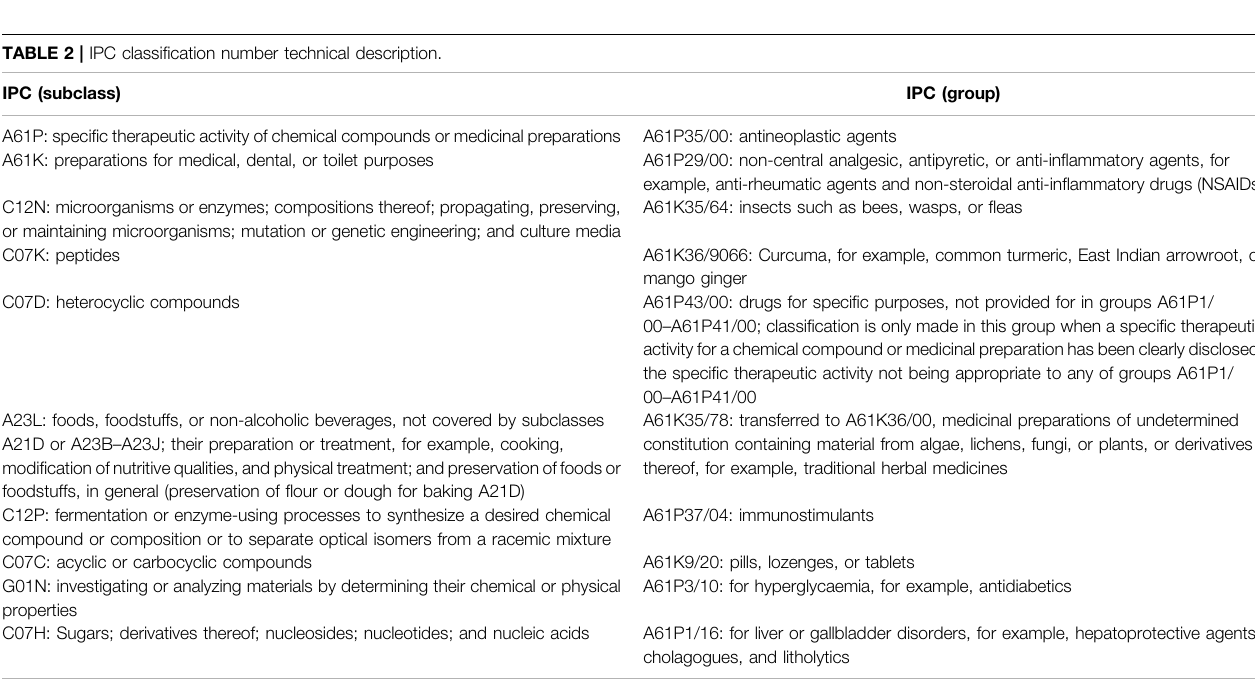
TABLE 2 | IPC classi fi cation number technical